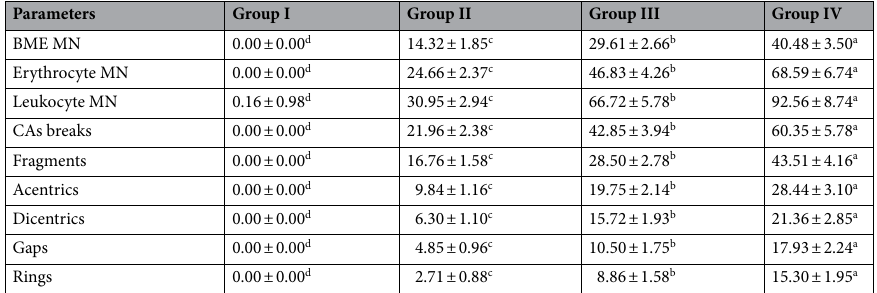
Table 3. Genotoxic effects of Paraquat. Group I: Control, Group II: 50 mg/kg b.w Paraquat, Group III: 100 mg/kg b.w Paraquat, Group IV: 200 mg/kg b.w Paraquat. MN micronucleus, BME buccal mucosal epithelium. Values are shown as mean ± SD (n = 6). For the frequency of MN 1.000 cells in each group and 600 cells for CAs were analyzed. Means shown with different letters on the same line are significantly different (p <